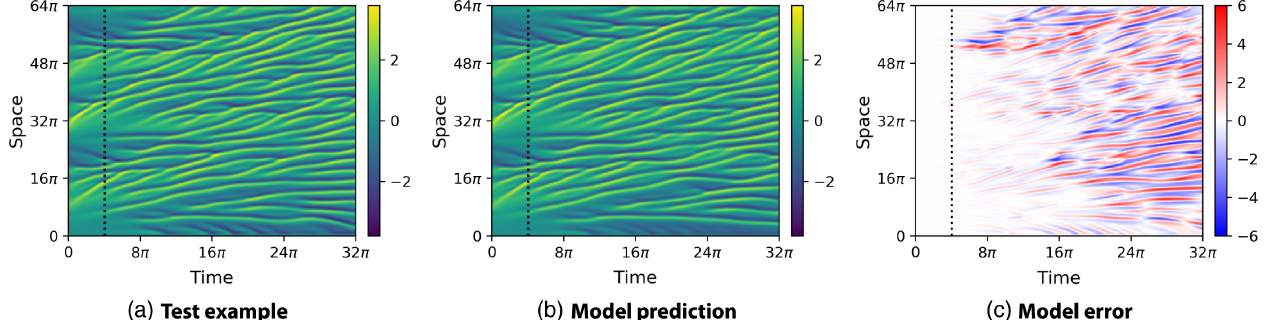
FIG. 9. Time evolution of (a) a 1D Kuramoto-Sivashinsky example with Dirichlet boundary conditions, (b) the predicted propagation using transferred kernels from the refined predictive model given the initial condition at time t ¼ 0 , and (c) the prediction error of the model. The refined predictive model for the 1D Kuramoto-Sivashinsky dataset was originally trained on data with periodic boundaries and is adapted — without retraining — to use Dirichlet hard wall boundaries instead by adjusting the padding at each propagation time step. The black vertical dotted line denotes the maximum amount of time propagated by the model during the original training, corresponding to the length of the target